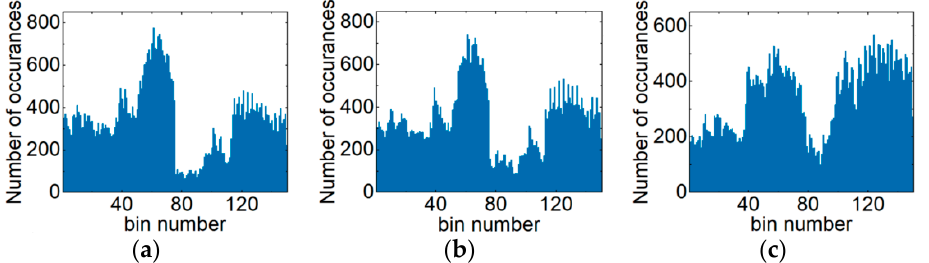
Figure 3. ACHs with different OSNRs in the PDM-S-16QAM system: ( a ) OSNR value is 21 dB, ( b ) OSNR value is 25 dB and ( c ) OSNR value is 30 dB.